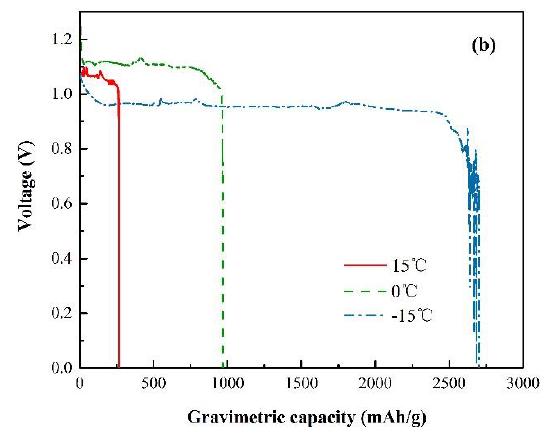
Figure 5. Discharging voltage profiles with a constant current density of 0.5 mA cm − 2 : ( a ) and 1.0 mA cm − 2 ; ( b ) by using 31 wt% KOH.